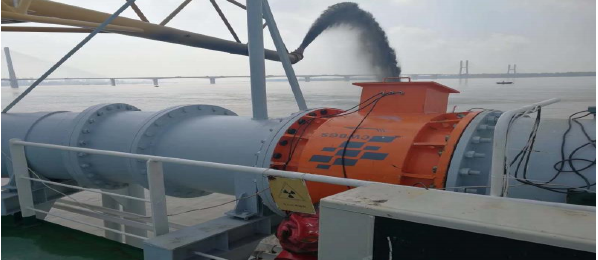
Figure 7. The γ -ray sensor in the pipeline.